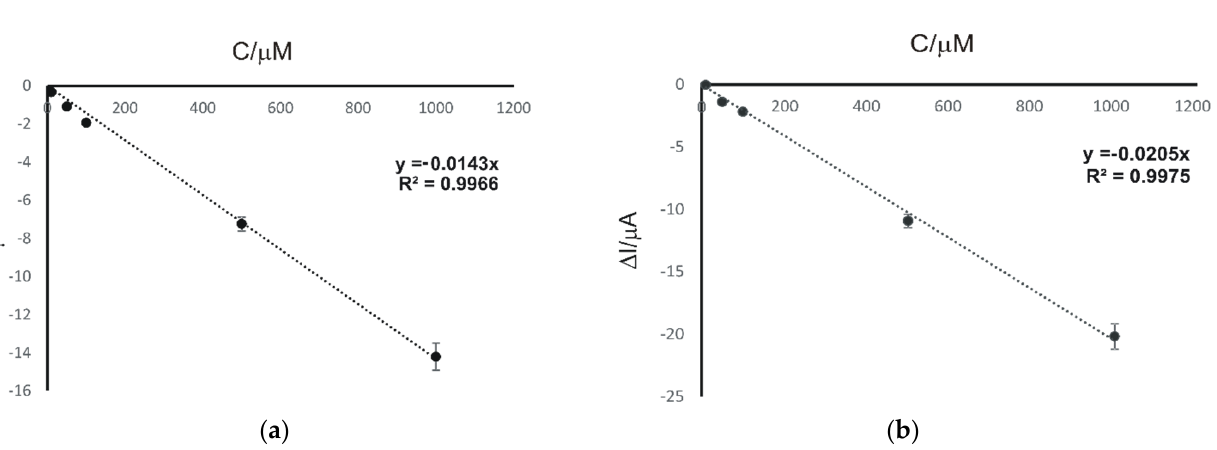
Table 2. Limit of detection (LOD) and limit of quantification (LOQ) values, line equation and R 2 of the CNF/SPE sensor for simultaneous detection of CA and FA.